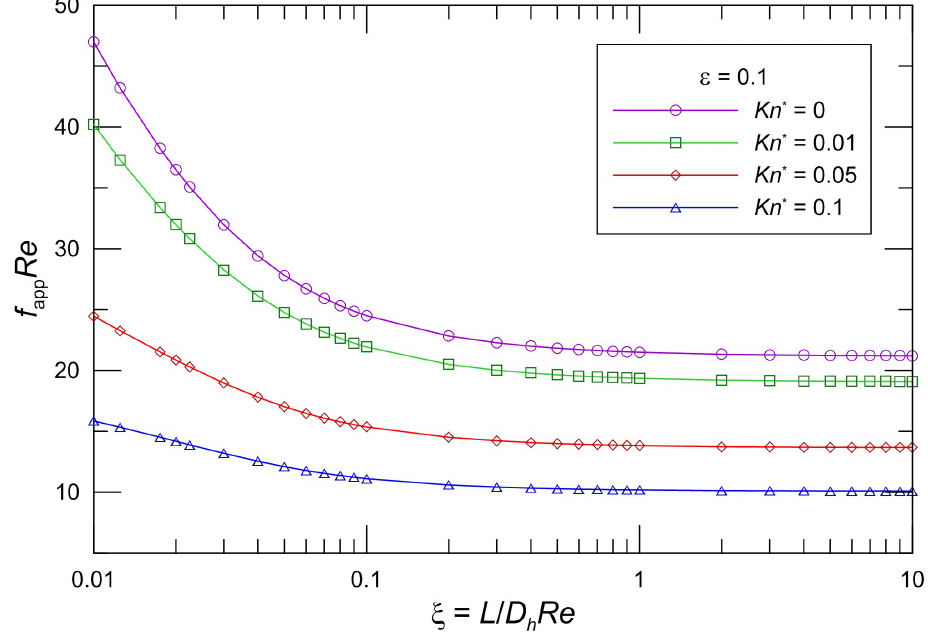
Figure 2 . Effect of Kn * on f app Re for rectangular ducts ( ε = 0.1).